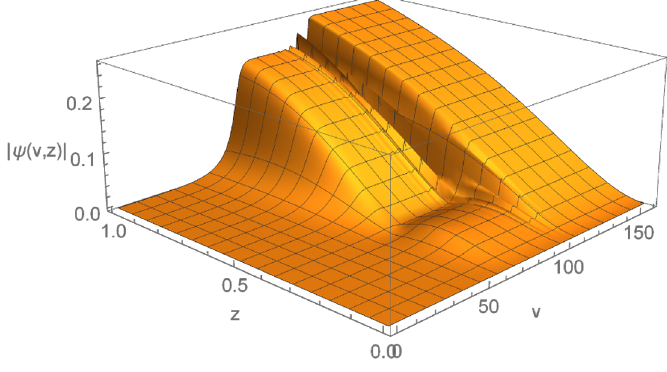
Figure 2 . The dynamics of scalar field for Q = 2 and q = 6 . 5 . The second eigenfunction of the linearized equation of motion is taken to be the initial condition for the scalar